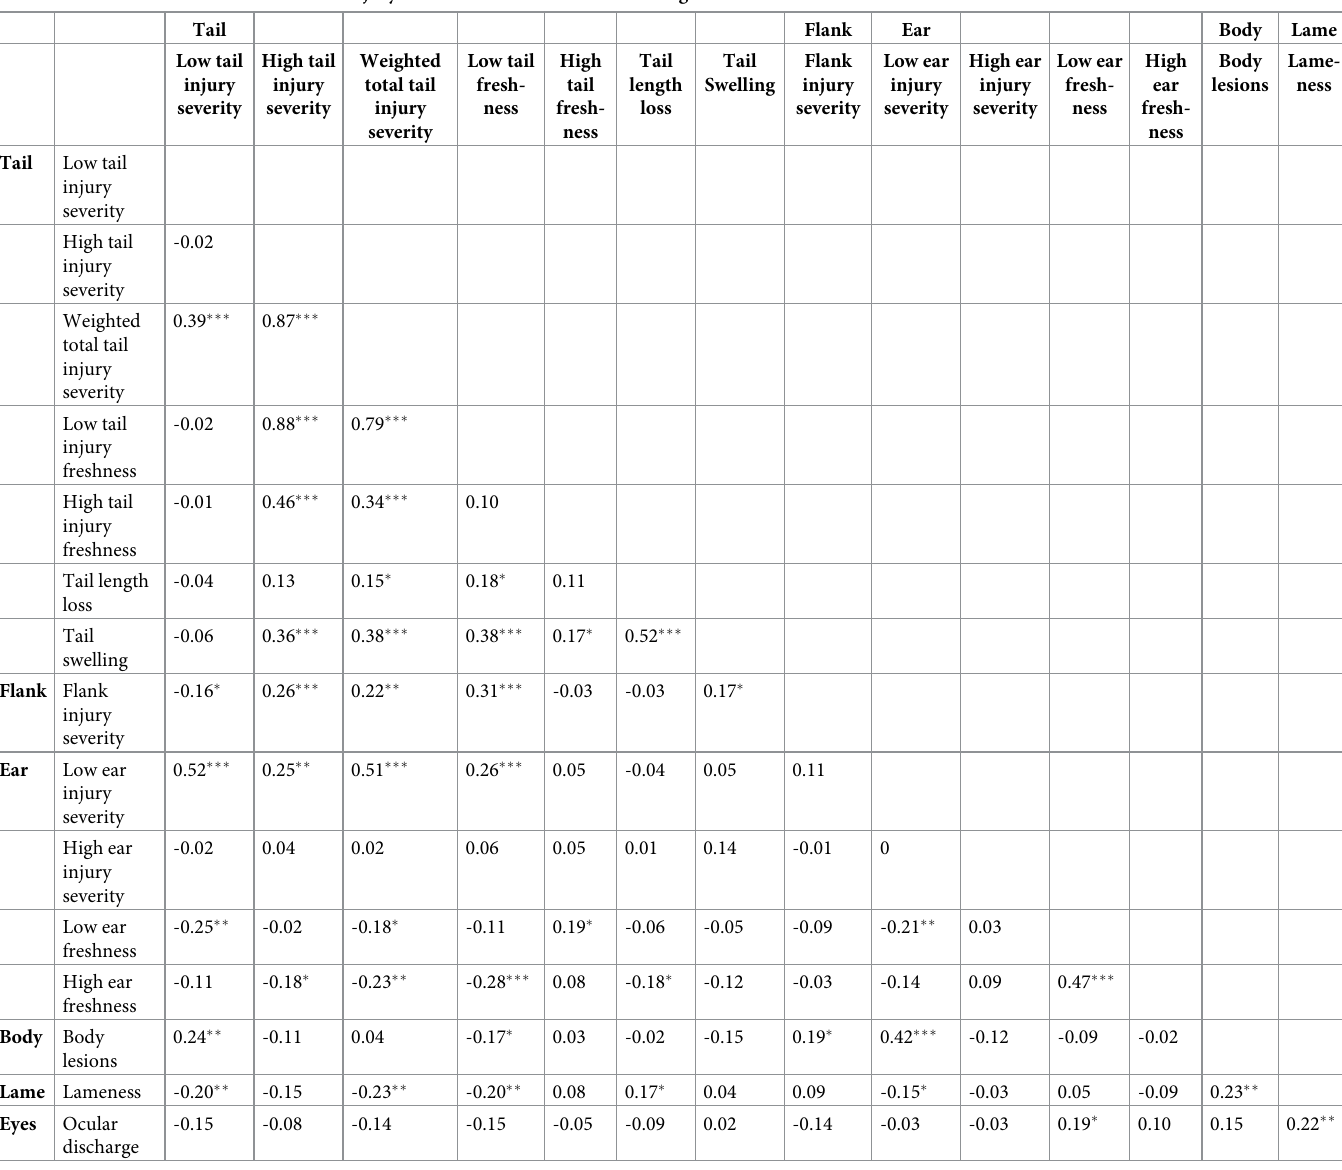
Table 3. Correlations between health and injury scores used in statistical